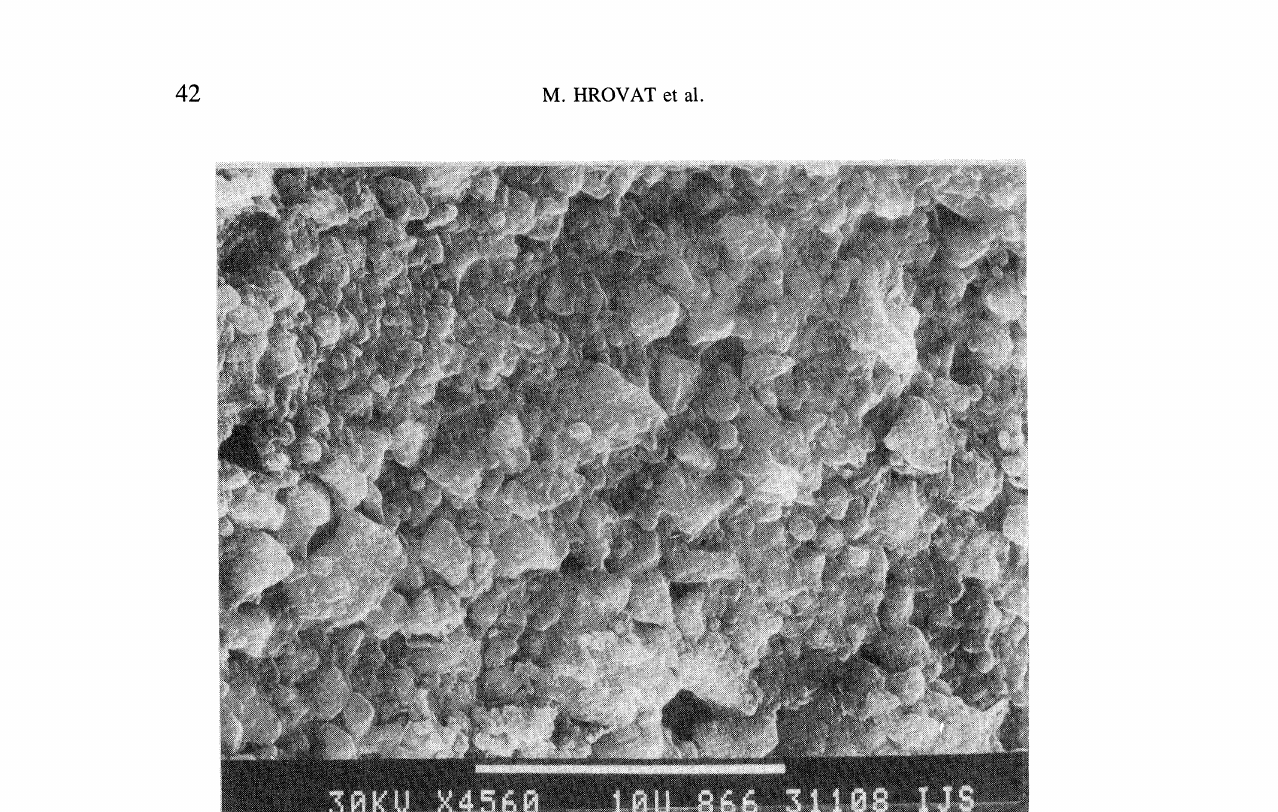
FIGURE 3 Microstructure of chromium paste, fired at 750C. The structure is poorly sintered due to surface oxidation of metal grains, 4560.